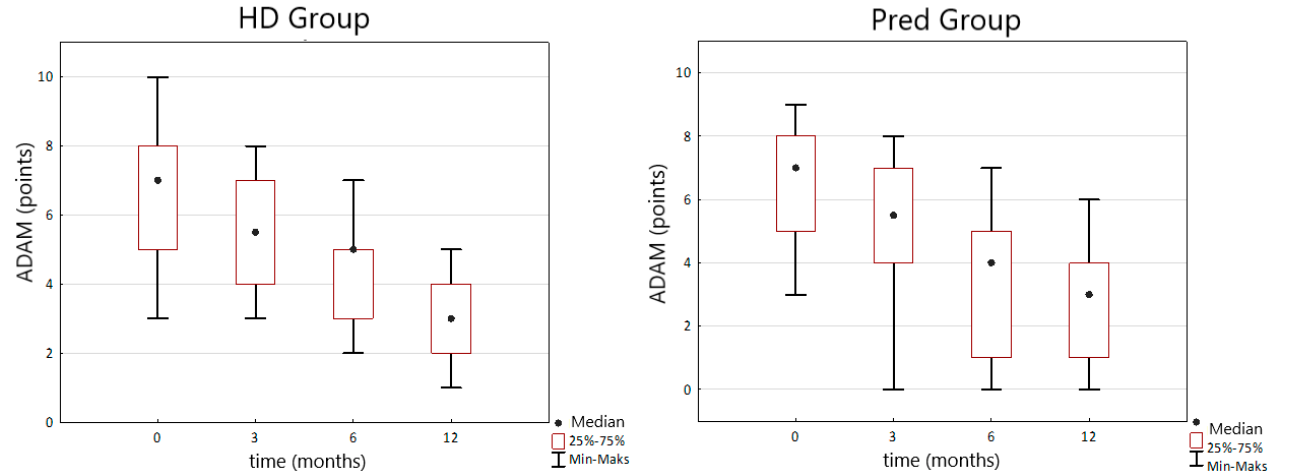
Figure 3. Changes in the ADAM (androgen deficiency in the ageing male) score during TRT (testos- terone replacement therapy) in the HD and PreD groups.